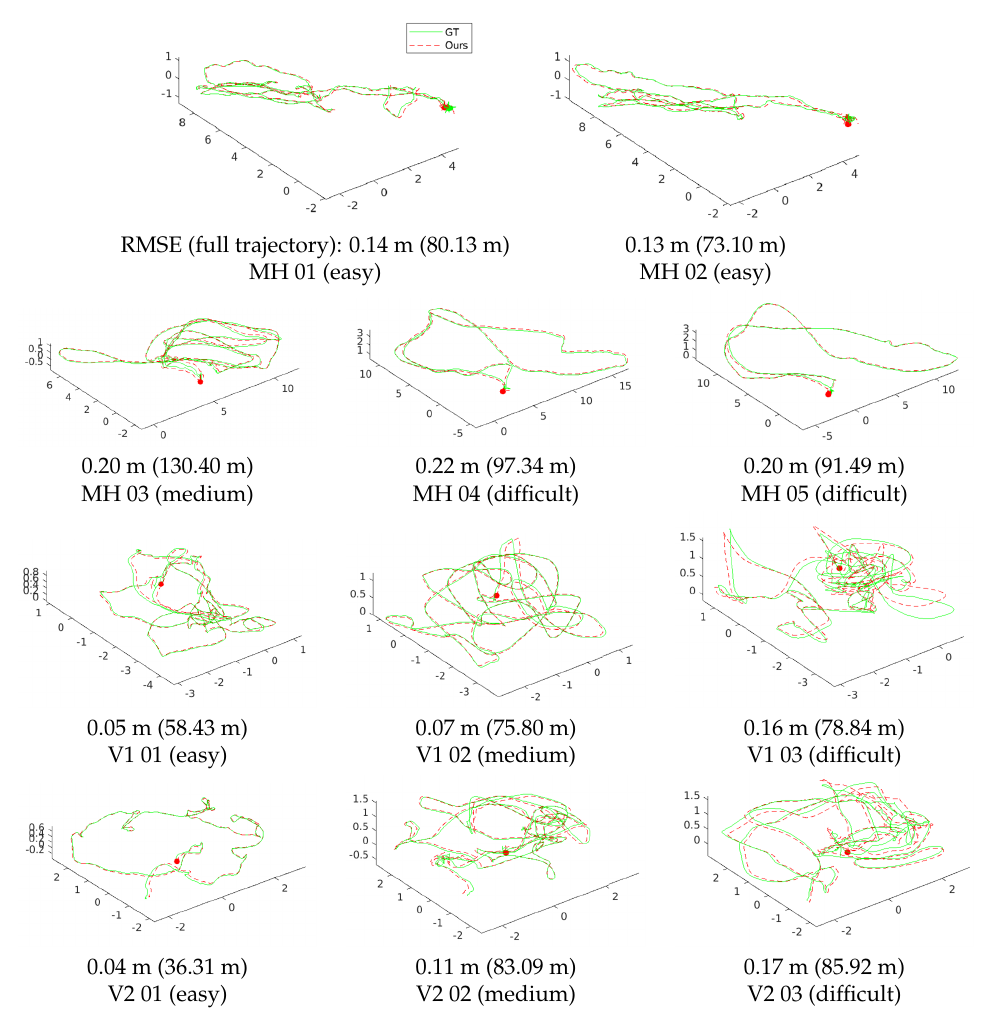
Figure 10. Comparison trajectory result of the proposed method with the ground-truth. Estimated trajectories are aligned to the ground-truth pose via SE ( 3 ) . The green line represents the ground-truth trajectory, and the red dashed line is ours. For overall sequences, the proposed method estimates the accurate poses without any failure cases in the tightly-coupled optimization framework with a robust initialization method using relative pose